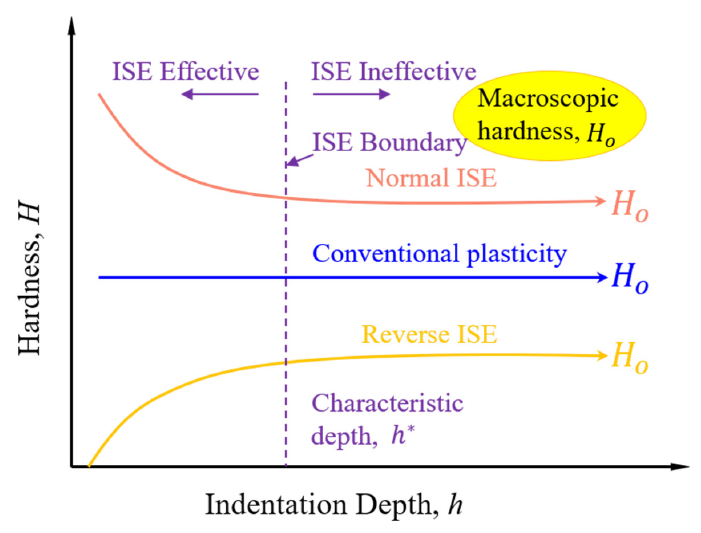
Figure 1. Schematic of indentation size effect (ISE) for geometrically self-similar indenters (Adapted and reported based on Pharr et al. [17]).